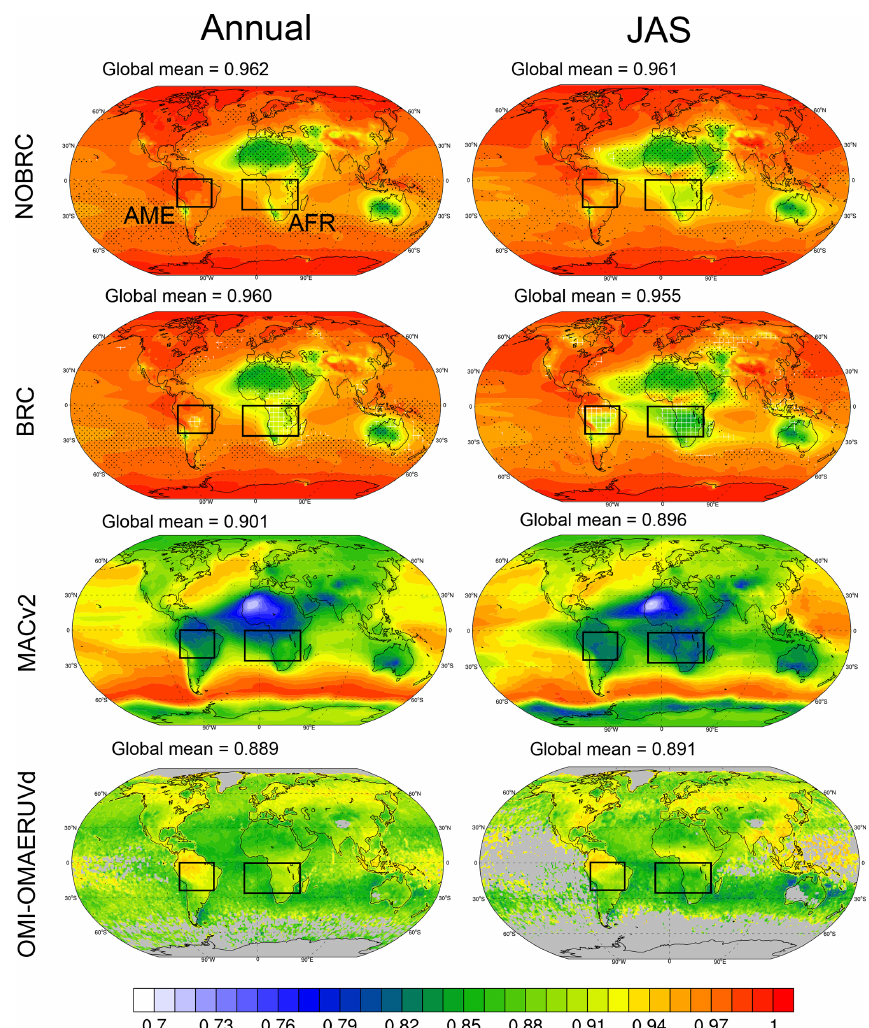
Figure 8. SSA (350nm) simulated by the ARPEGE-Climat model for the NOBRC and BRC simulations and retrieved from MACv2 and OMI-OMAERUVd (see Tables 2 and 3 for details) averaged over the year and over the months of July, August, and September (JAS). Black dots in the model plots show common locations between the NOBRC and BRC simulations where the SSA is inside the range covered by MACv2 and OMI-OMAERUVd (reference data set uncertainties included; AERONET uncertainties are used when data are not available). Changes in these locations between the NOBRC and BRC simulations are highlighted by white hatching. Shaded areas indicate a missing